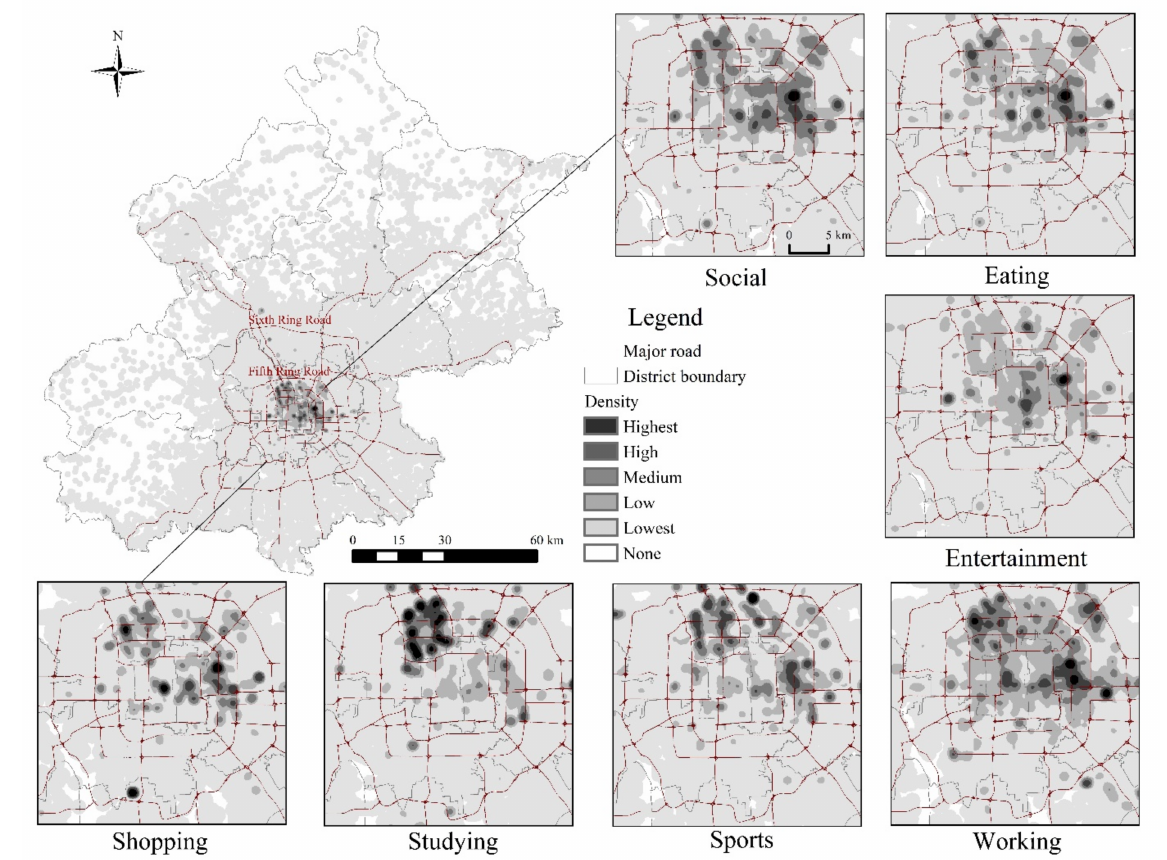
Figure 6. The kernel density distribution of overall activity and various daily activities. Table 5. The spatial distribution characteristics of various activities and hotspot